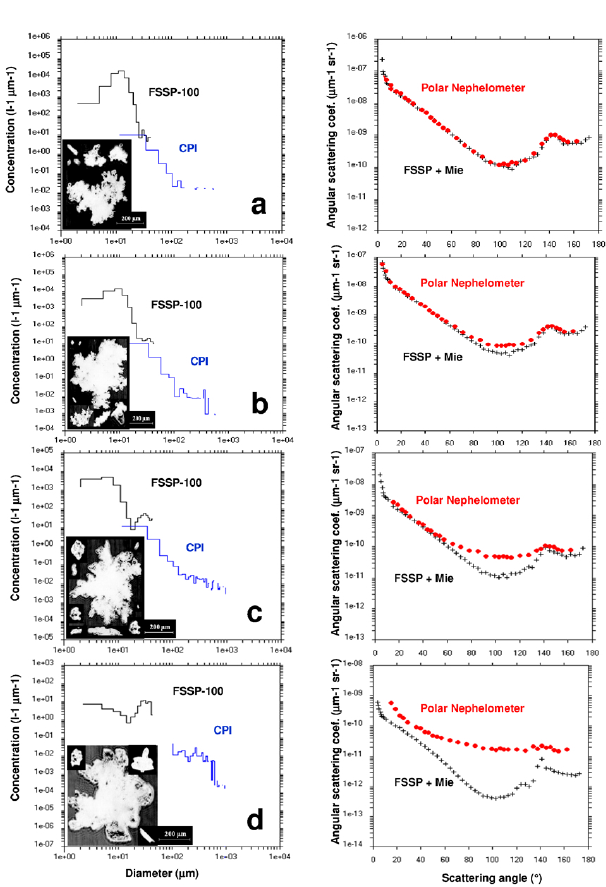
Fig. 4. Results obtained for the four cloud sequences labelled a, b, c and d on Fig. 1. Left panels: Mean particle size distributions from FSSP and CPI measurements with examples of ice crystal im- ages. Right panels: Mean measured scattering phase function (Polar Nephelometer with red dots symbols). The theoretical phase func- tions are calculated from the FSSP data with the Mie theory and plotted with black cross